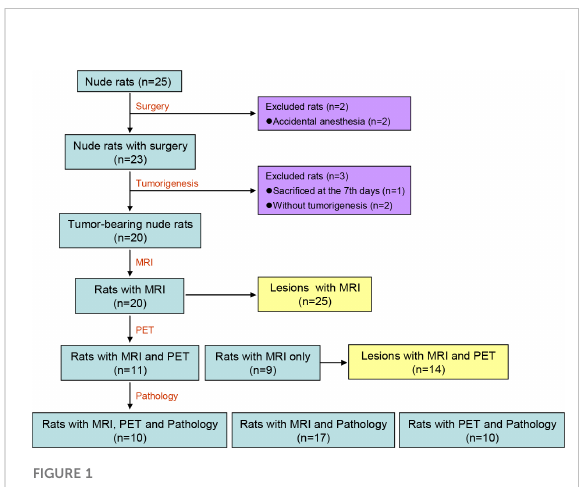
FIGURE 1 Flow Chart of the included nude rats and tumor lesions. MRI, magnetic resonance imaging; PET, positron emission computed